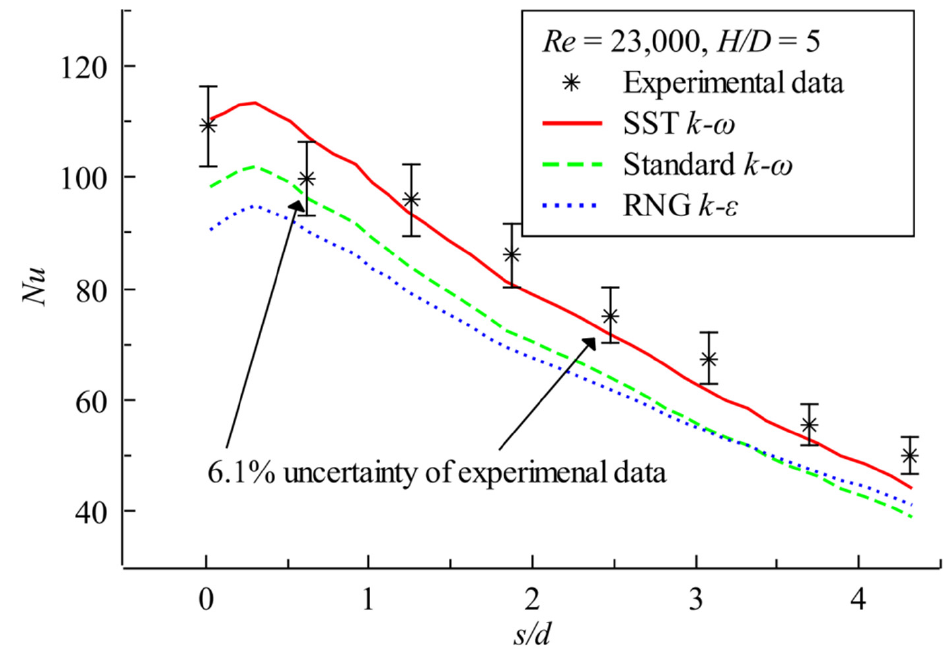
Figure 4. Validation of numerical methods.